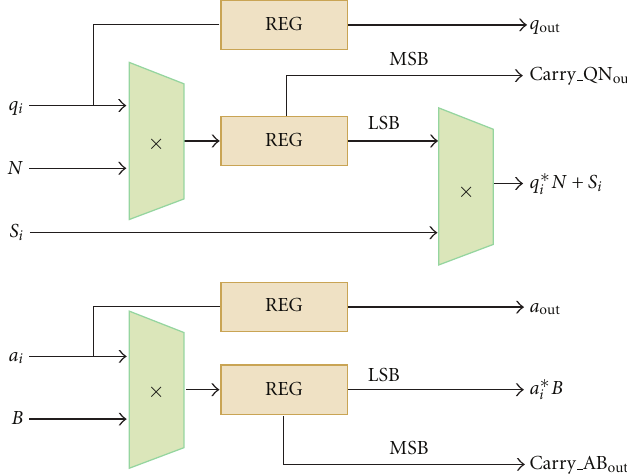
Figure 9: Multiplier block architecture.